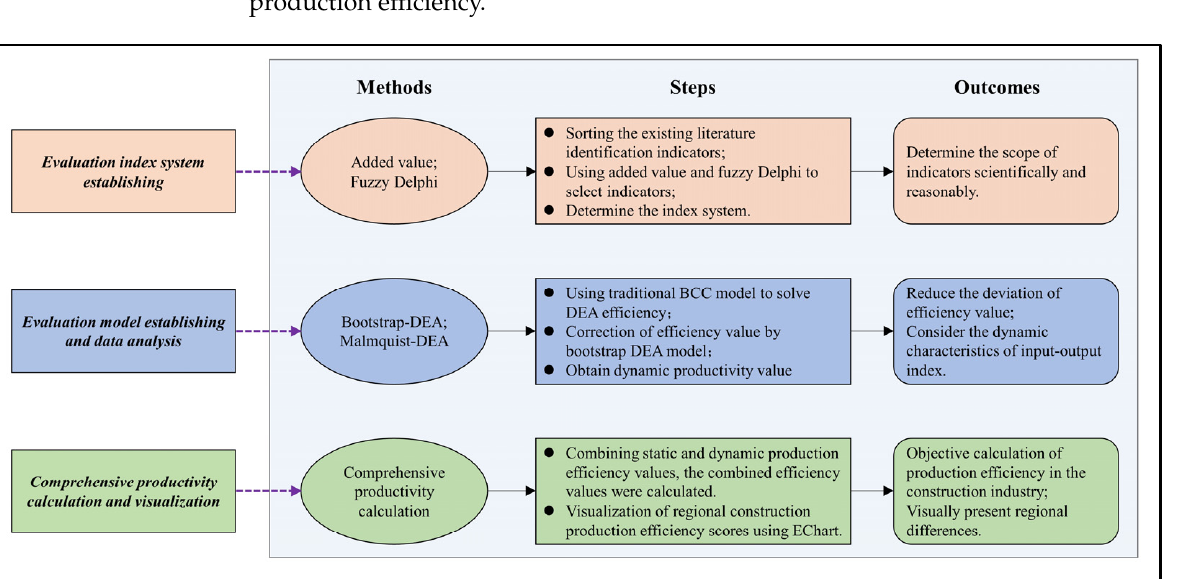
Figure 1. Research framework.